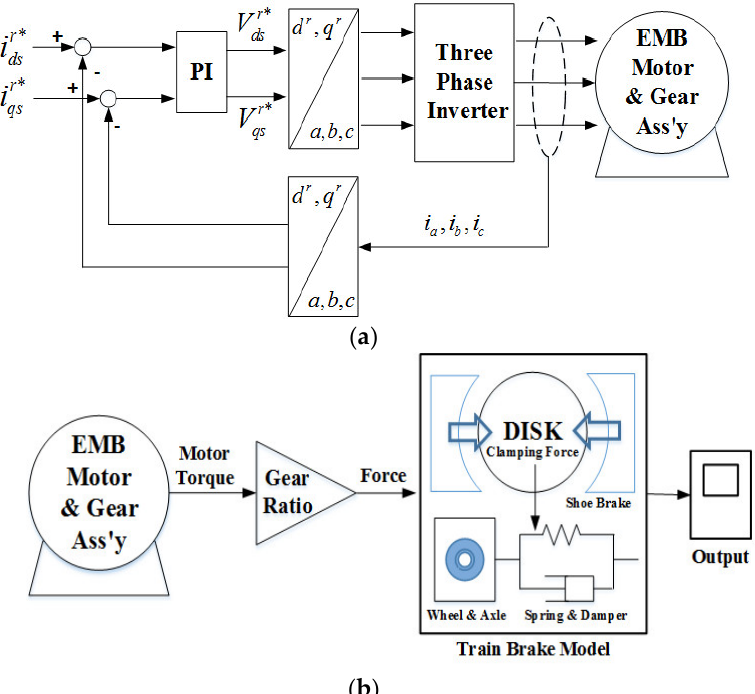
Figure 3. Simulation concept of EMB for Matlab/Simulink: ( a ) SPMSM current control concept diagram for EMB control; ( b ) train brake model for mechanical parts.